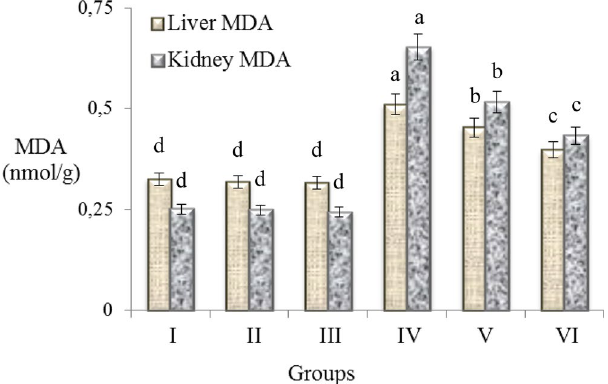
Figure 3. Effects of AFB 2 and resveratrol on MDA levels, an indicator of lipid peroxidation in liver and kidney cells. Group I: control, Group II: 10 mg/kg b.w resveratrol, Group III: 20 mg/kg b.w resveratrol, Group IV: 20 µg/kg b.w AFB 2 , Group V: 10 mg/kg b.w resveratrol + 20 µg/kg b.w AFB 2 , Group VI: 20 mg/kg b.w resveratrol + 20 µg/kg b.w AFB 2 . Each histogram is a decimal average. The vertical lines on the bars indicate the standard error. Different letters (a–d) indicated averages p < 0.05 is important.